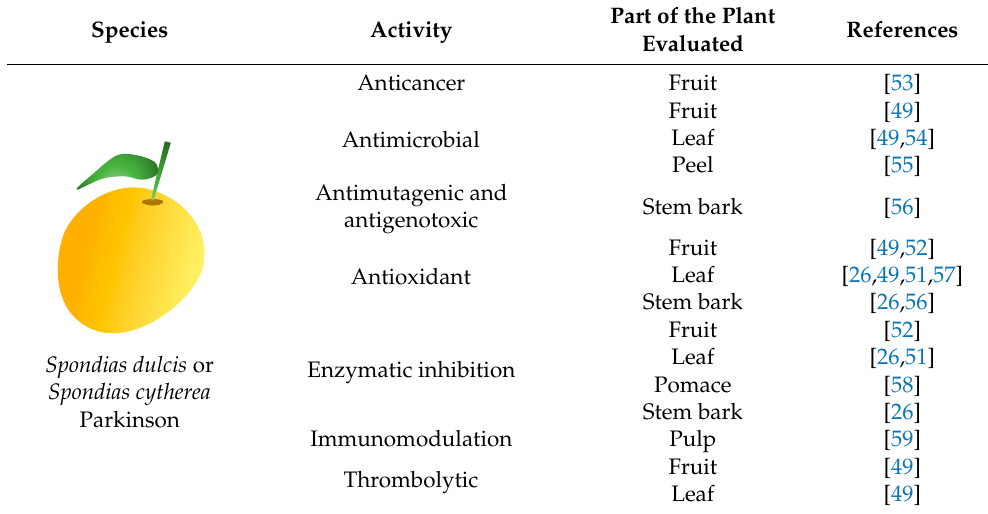
Table 2. Summary of Spondias dulcis activity in different parts of the plant, as described in the last few years.